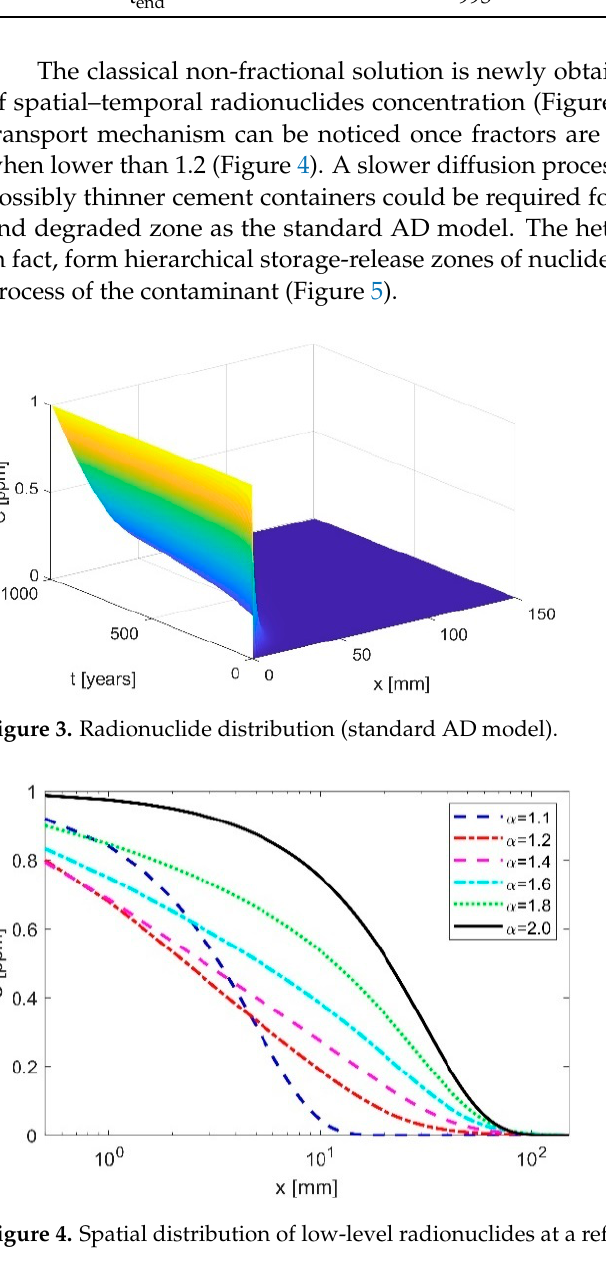
Figure 5. Time history of radionuclides at a reference node. 4. Discussion A nonlinear coupled 3D fractional hydro-mechanical model accounting for anoma- lous diffusion (FD) and advection–dispersion (FAD) for solute flux is presented, ac- counting for a Riesz derivative treated through the Grünwald–Letnikow definition. The formulation innovatively includes the contribution of deformation non-linearities for the solid skeleton, as well as a strain-dependent permeability tensor. A finite difference ap- proximation is built on purpose for modeling 1D domains and adopting the fraction- al-centered derivative scheme combined with the β -method, with the advective term treated via the Lax–Wendroff scheme. In particular, the algorithm shifts into a back- ward-time implicit one with variable time steps in case of long-term contaminants (ra- dionuclides) transport. Under the assumptions of linear-type pore pressure distribu- tions, permeability which is weakly dependent on deformation, together with small volume changes, means that the effects of the fractional dispersion term are analyzed. A delayed release of solute pollutants or a long-tailed dispersion process caused by volume heterogeneities of the porous media was successfully described, evidencing a general gradual and slower solute contaminant transport. Additionally, when account- ing for radionuclides transport within cemented materials and decreasing fractors, the model evidences a sort of solute-clog, with higher solute gradients and increasing solute levels. Correspondingly, it appears to be particularly suitable for reconstructing phe- nomena in which the kinetics of diffusion are slower than the kinetics of reaction and layers of very low solubility form and do not dissolve on observable time scales. Author Contributions: Conceptualization, methodology, writing—original draft preparation and writing—review and editing, V.A.L.S.; software, data curation and investigation, N.D.M. All au- thors have read and agreed to the published version of the manuscript.